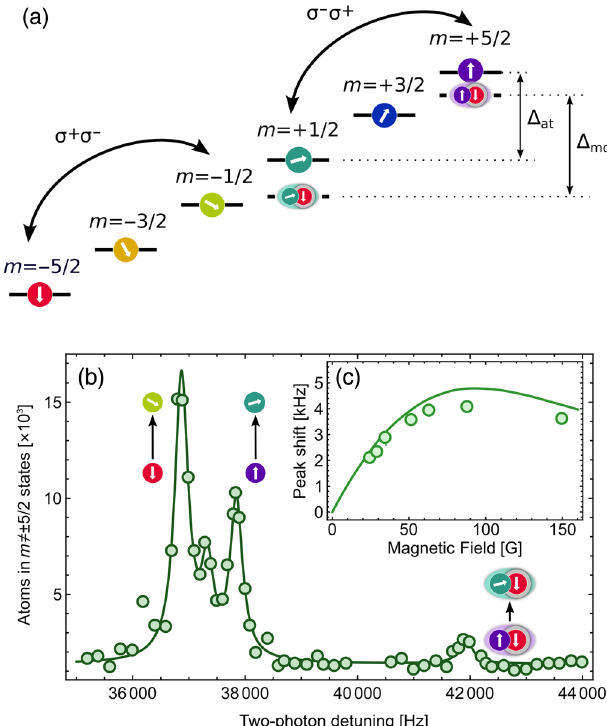
FIG. 5. (a) Scheme of the two-photon Raman transitions connecting different nuclear-spin states. The energy Δ corre- at sponding to a Raman spin flip of individual atoms differs from the energy Δ needed to flip the spin of the ground-state atom in the mol orbital molecule (because of the different binding energies for different spin states). (b) Raman spectroscopy of a sample containing individual atoms with m ¼ (cid:2) 5 = 2 and orbital mole- ¼ 15 . The peaks at lower frequency cules at B ¼ 88 G and s f correspond to the spin flipping of individual atoms while the small peak near 42 kHz corresponds to a bound-to-bound transition between orbital molecules made of different spin mixtures. (c) Shift of the bound-to-bound transition peak mea- sured as a function of the magnetic field. The solid line is the binding energy difference between the initial and final molecular states calculated from our model (see Sec. III).